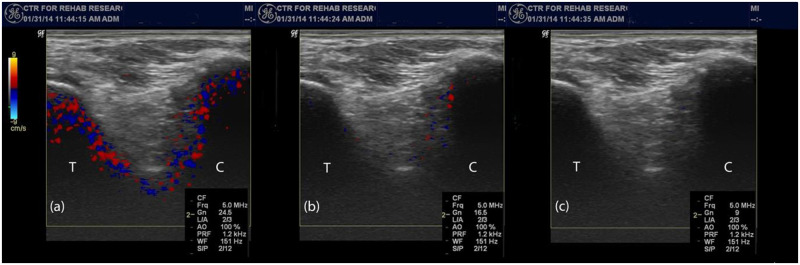
Color Doppler images of the STJ from the lateral side in three different levels of Threshold Unit (TU) settings.(a) with TU setting high, vibration detected on both talus and calcaneus as recognizable by color pixels on both talus and calcaneus; (b) vibration no longer detected in talus = TUtalus; as recognizable by missing color pixels on talus; (c) vibration no longer detected in calcaneus = TUcalcaneus: as recognizable by missing color pixels on calcaneus: T = talus and C = calcaneus.